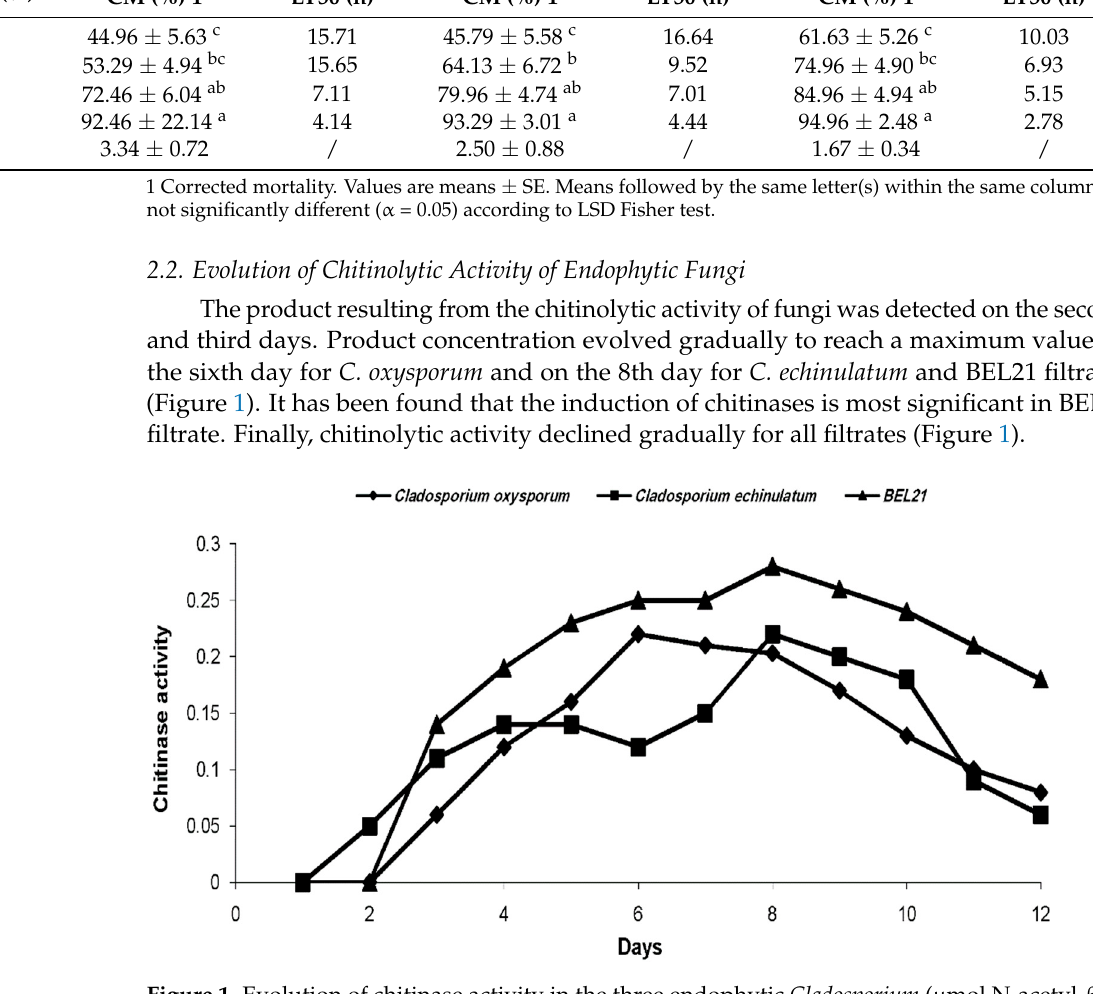
Figure 1. Evolution of chitinase activity in the three endophytic Cladosporium ( μ mol N-acetyl- β -D- glucosamine min · mL − 1